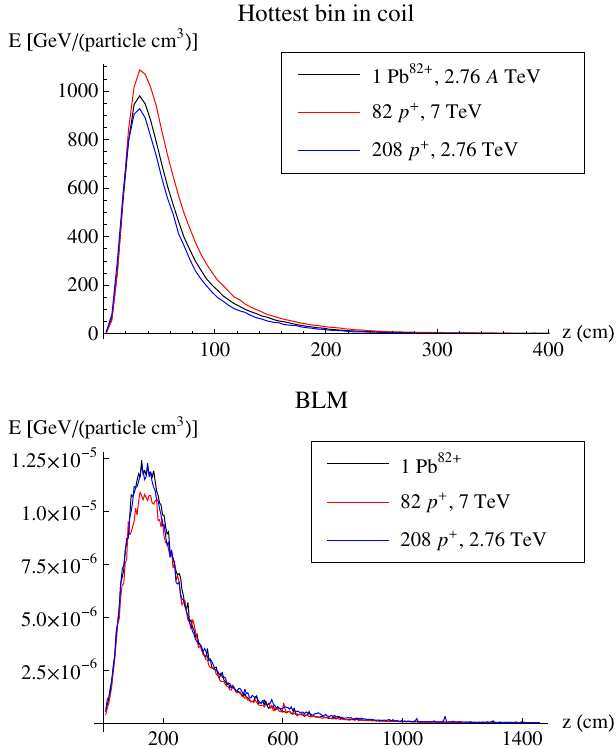
FIG. 18. (Color) The energy deposition in the hottest wire in the gas inside the ionization chamber for Pb ions coil and in the N 2 and protons. The three cases are scaled to equivalent total energy of incoming